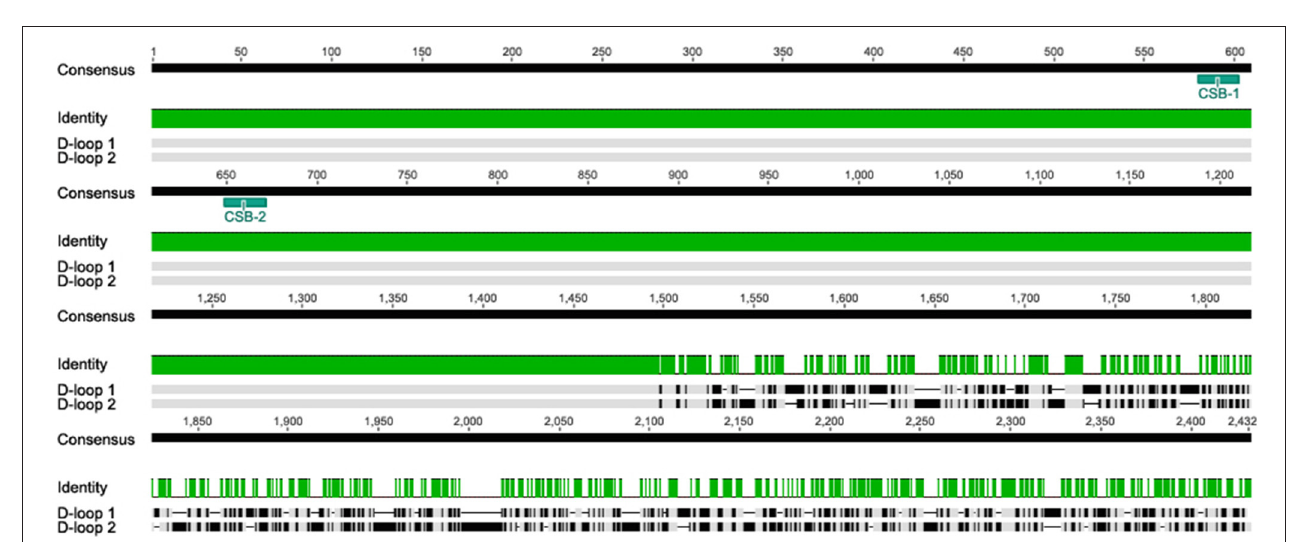
FIGURE 5 | Pairwise alignment of mitochondrial Alim-D-loop 1 and Alim-D-loop 2 using MUSCLE. The alignment reveals a 1497 bp segment with 100% similarity in the 5 ′ region, with a highly divergent region toward the 3 ′ end. The duplicated regions also contain duplicated CSB-1 and CSB-2.